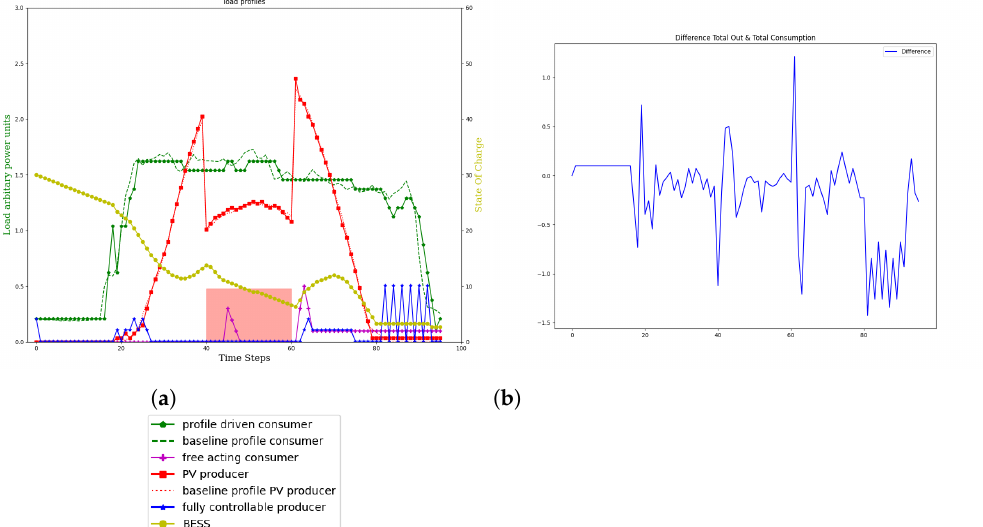
Figure 17. Evaluation of stress on day 1 (generalised), with the PV agent stressed moderately. ( a ) Agent load curves and profiles. ( b ) Load balancing difference.